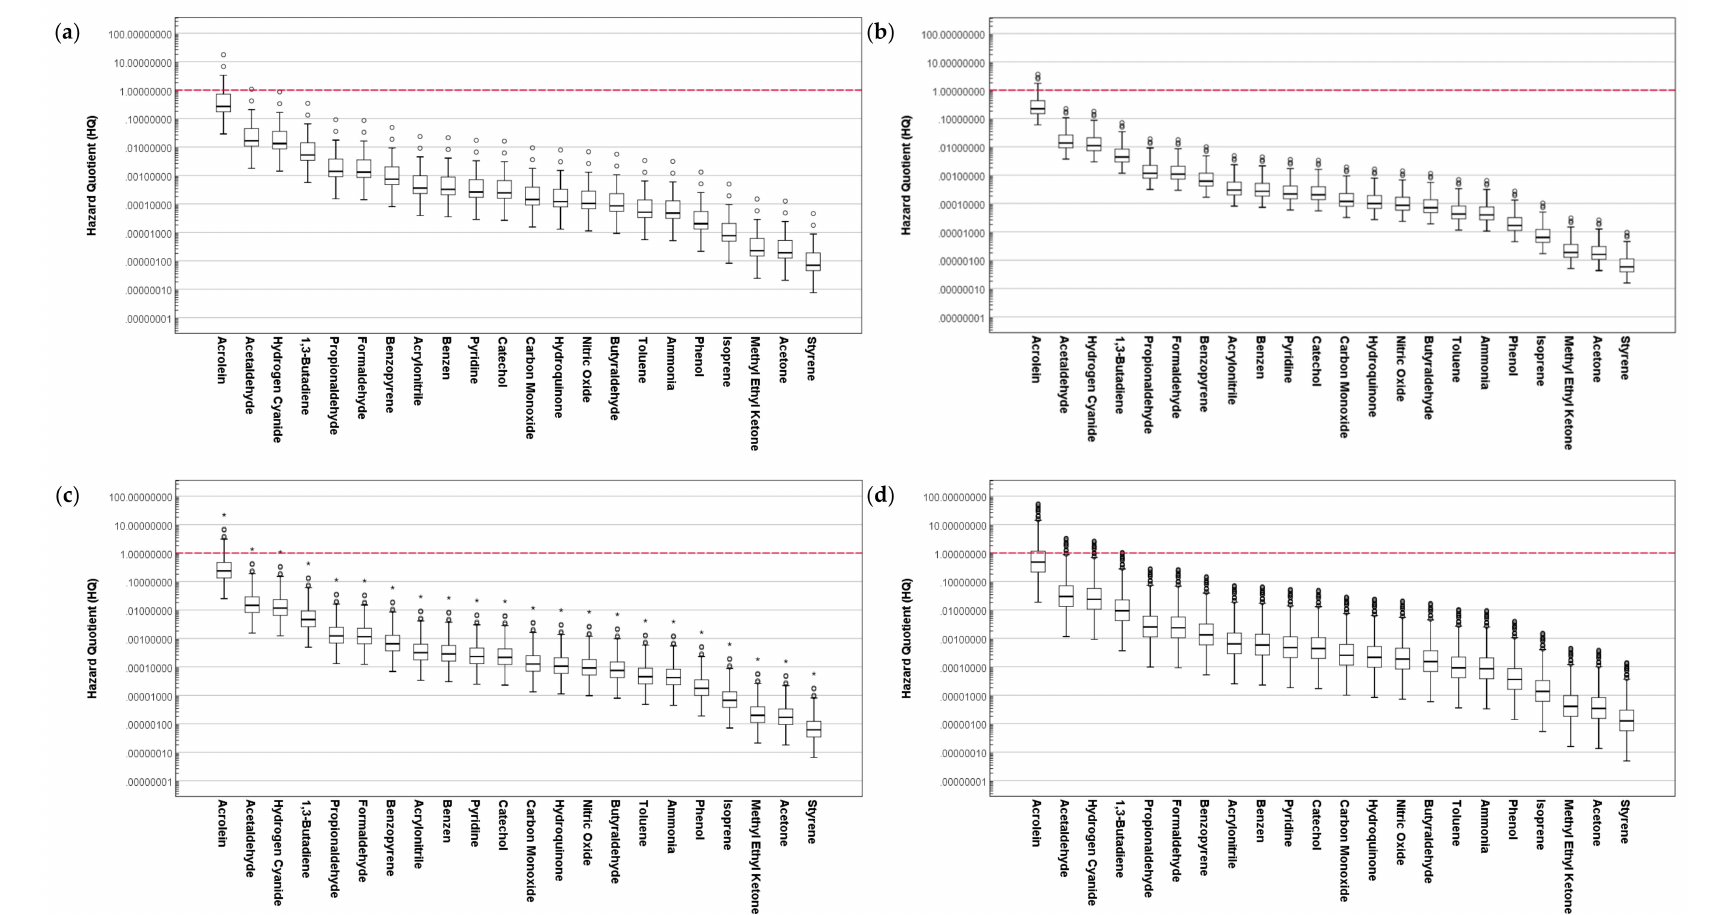
Figure 3. Assessment of hazard quotient for the composition of cigarette smoke to SHS exposure subjects based on age: ( a ) 6–10 years old, ( b ) 11–13 years old, ( c ) 14–18 years old, and ( d ) 19 years old and